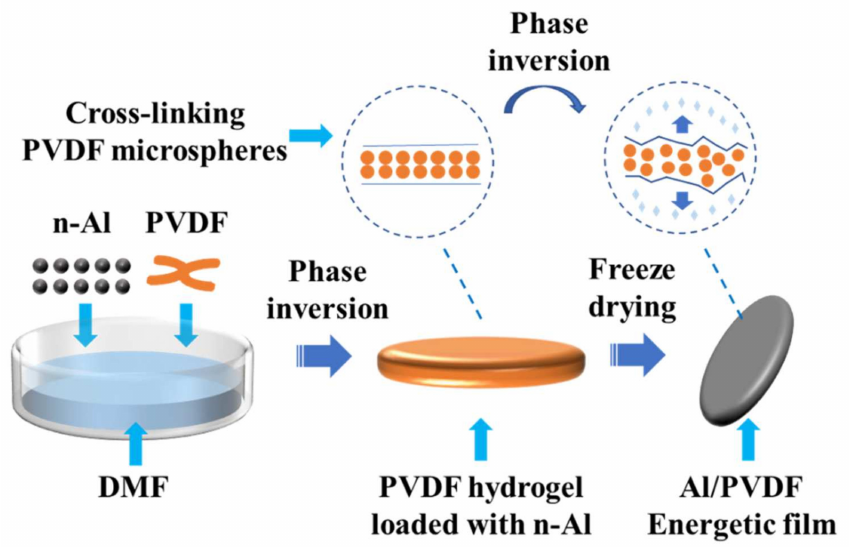
Figure 8. Schematic diagram of the preparation